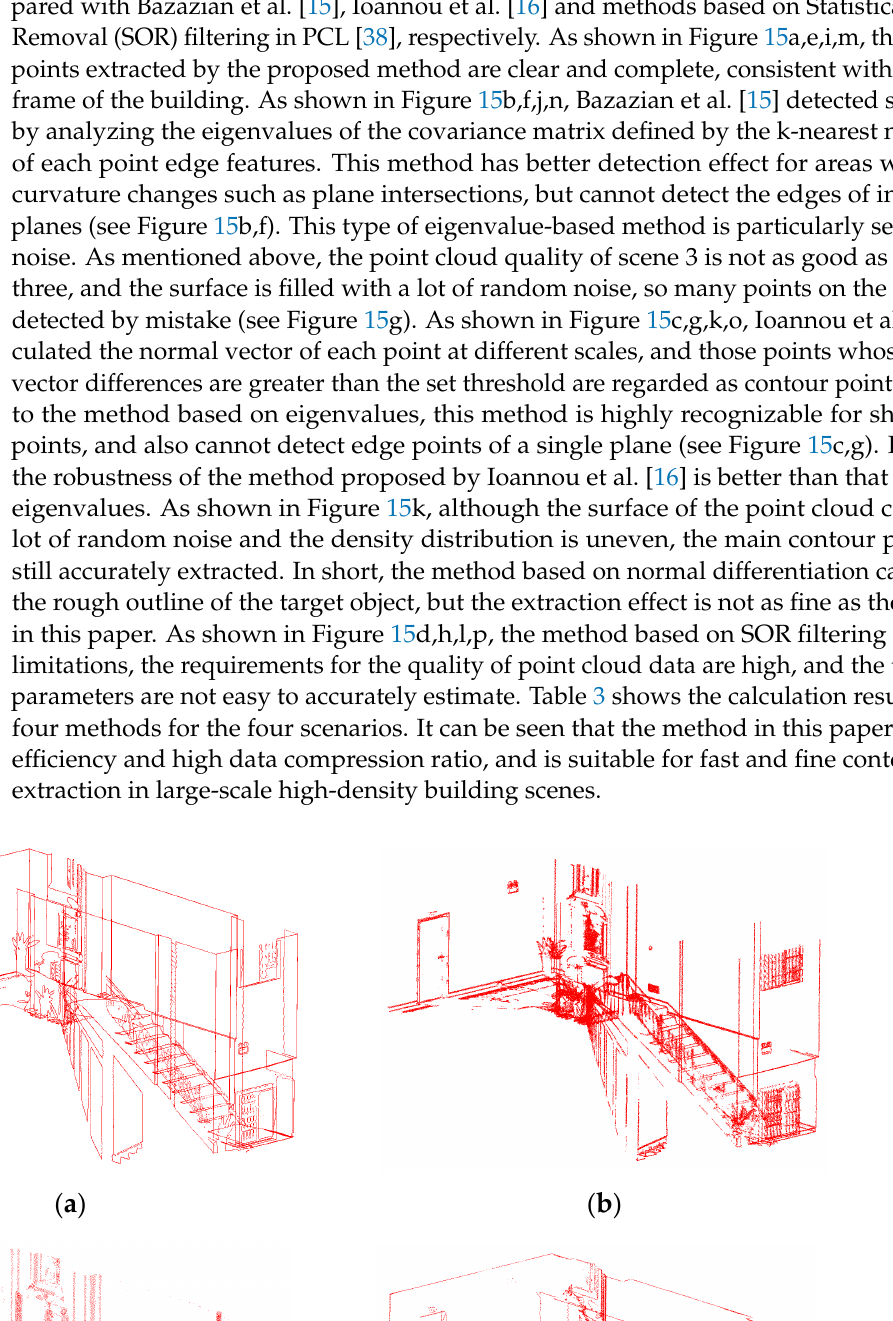
Figure 14. Three-dimensional line segments extracted by the method of Lu et al. [25]. Each scene is shown from two angles. ( a , b ) Staircase. ( c , d ) Corridor. ( e , f ) Laboratory. ( g , h ) Lounge.